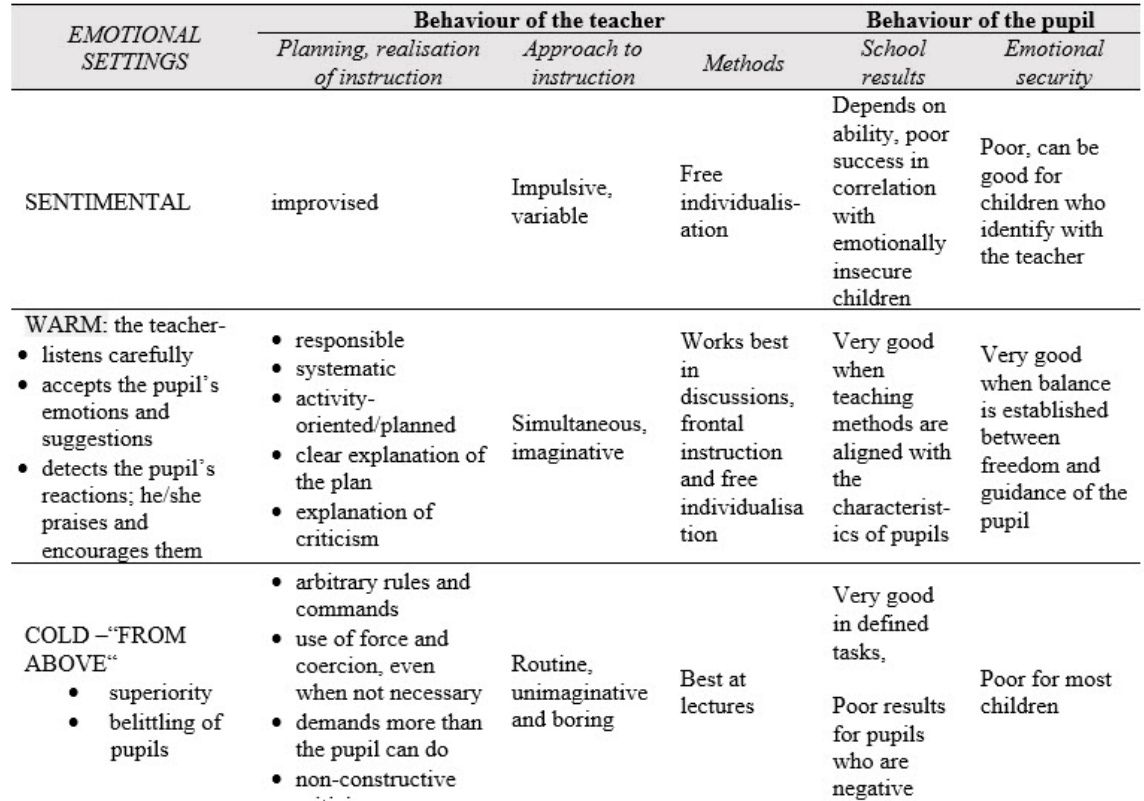
Table 1. Totality of behaviour of pupils and